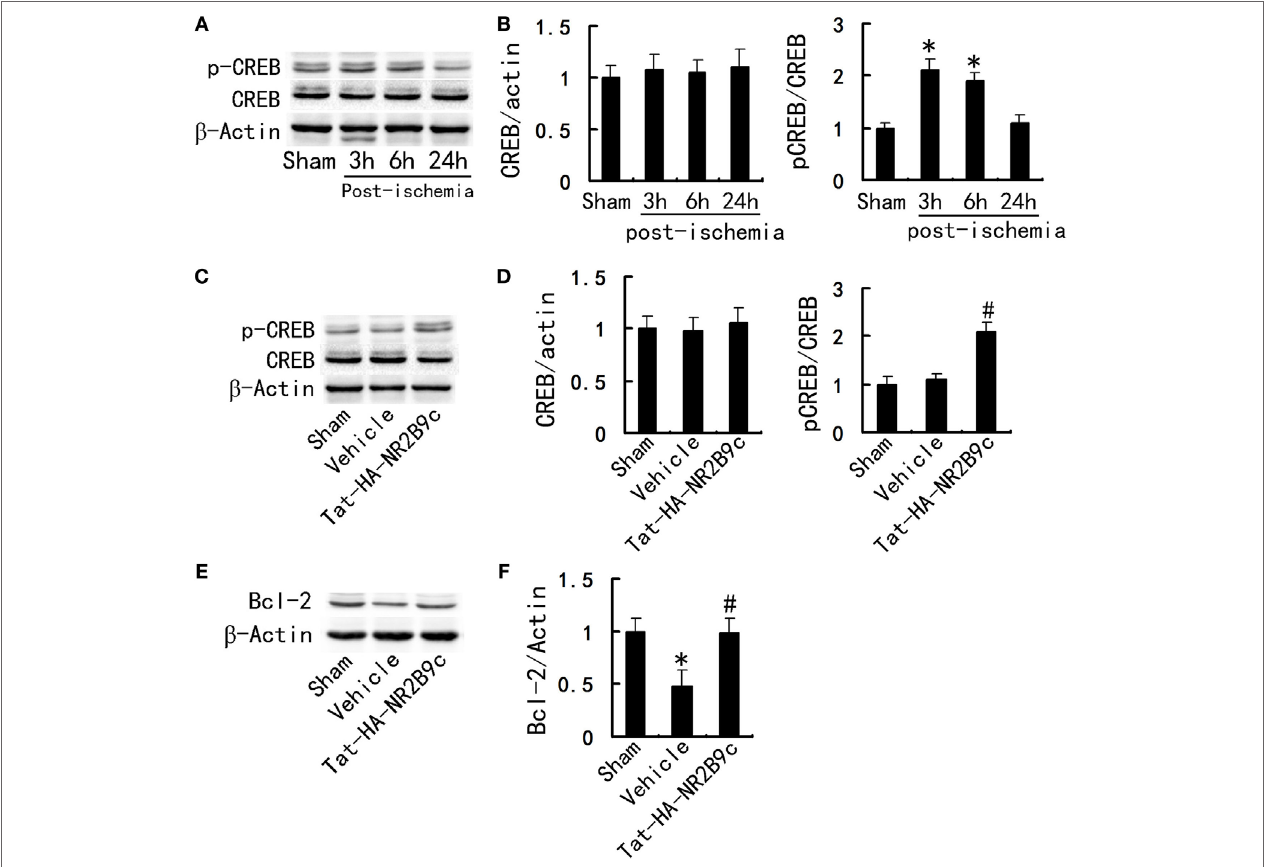
FigUre 3 | Tat-HA-NR2B9c increases the phosphorylation of CREB and elevates B-cell lymphoma-2 (Bcl-2) expression in the hippocampal CA1 region after transient global ischemia (TGI). (a) Immunoblots of phosphor-CREB (p-CREB) and CREB levels at serial time points following ischemia. (B) Statistical graph from data in (a) , n = 5. (c) Immunoblots of CREB, p-CREB in the CA1 region of rats treated with vehicle or Tat-HA-NR2B9c for 24 h following TGI. (D) Statistical graph from data in (c) , n = 5. (e) Immunoblots of Bcl-2 in the hippocampal CA1 region of rats treated with vehicle or Tat-HA-NR2B9c for 24 h following TGI. (F) Statistical graph from data in (e) , n = 5. Data are mean ± SEM (* P < 0.05 vs sham; # P < 0.05 vs